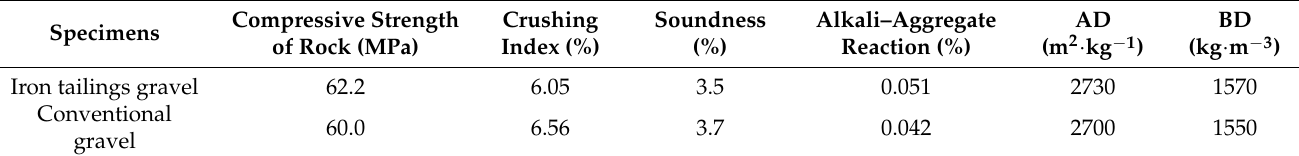
Table 4. Main technical indices of coarse aggregate.